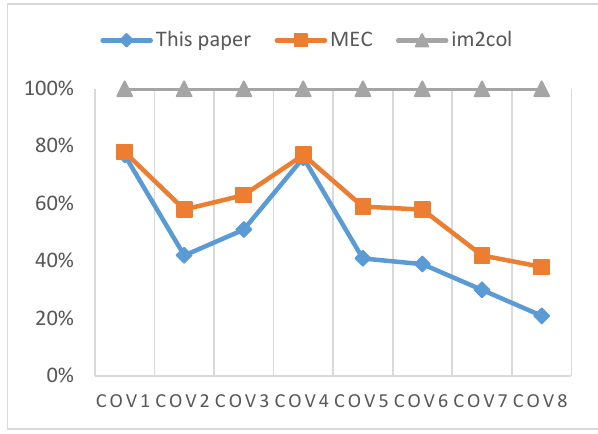
Figure 16. The running time between different convolution conversion algorithms.